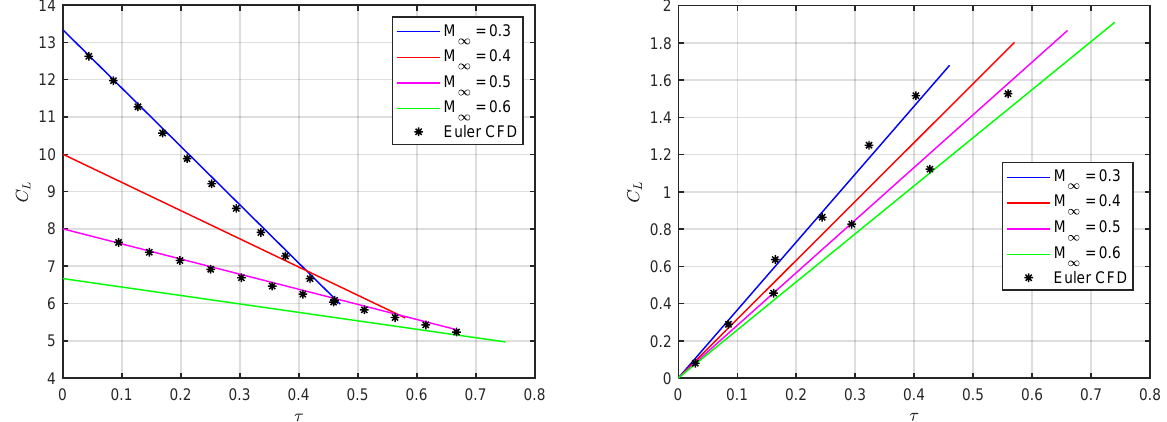
Figure 14. The incipient indicial lift for rectangular straight wing in compressible flow: AOA ( left ) and SEG ( right ), with η = 20 and Λ = 0 ◦ .